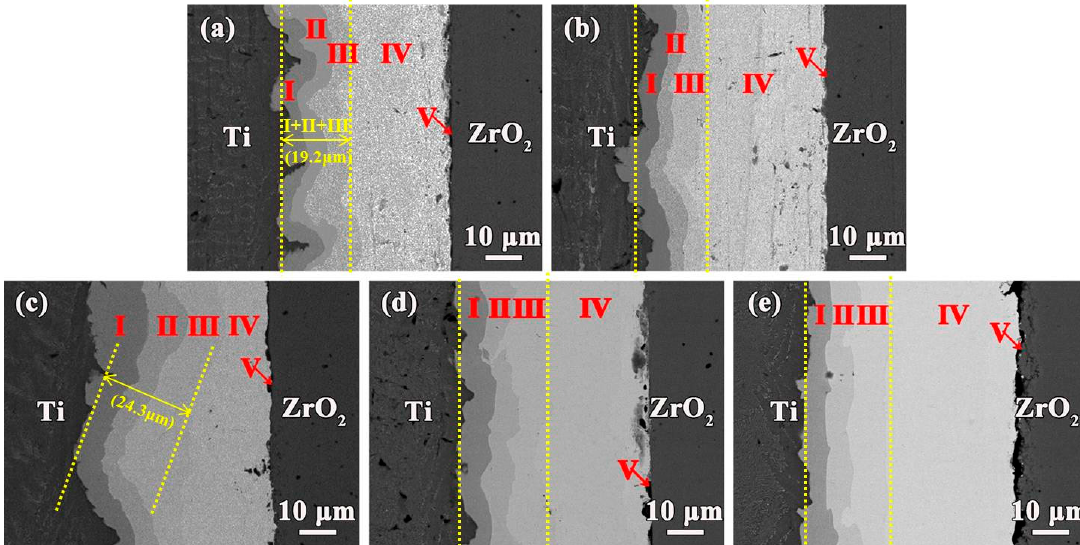
/ Au / ZrO ff erent brazing temperatures for 2 joint brazed at di